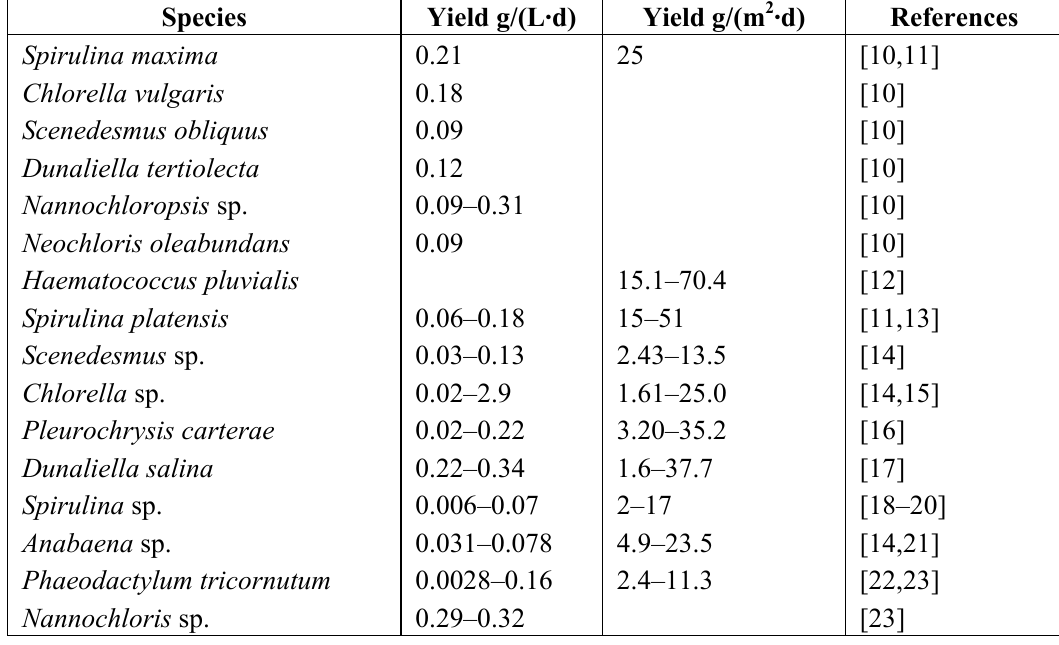
Table 2. Biomass production of several microalgae spp. in open